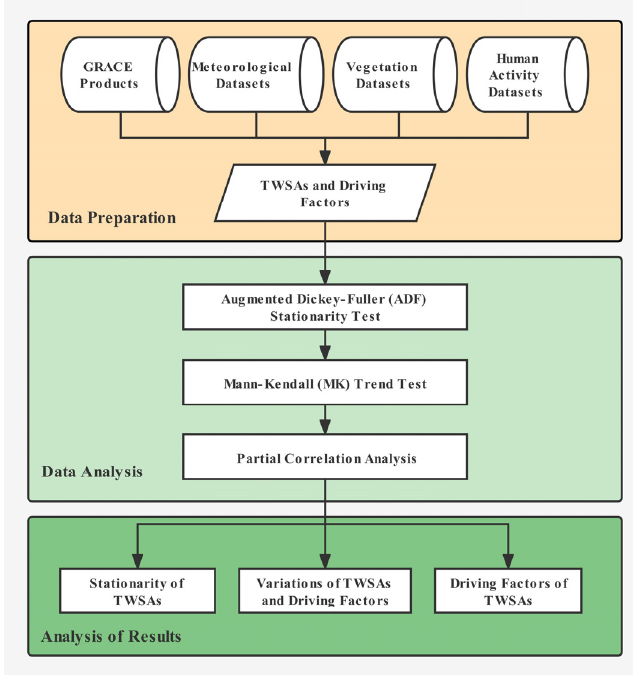
Figure 3. Research design. Table 2. The summary of driving factors for watershed